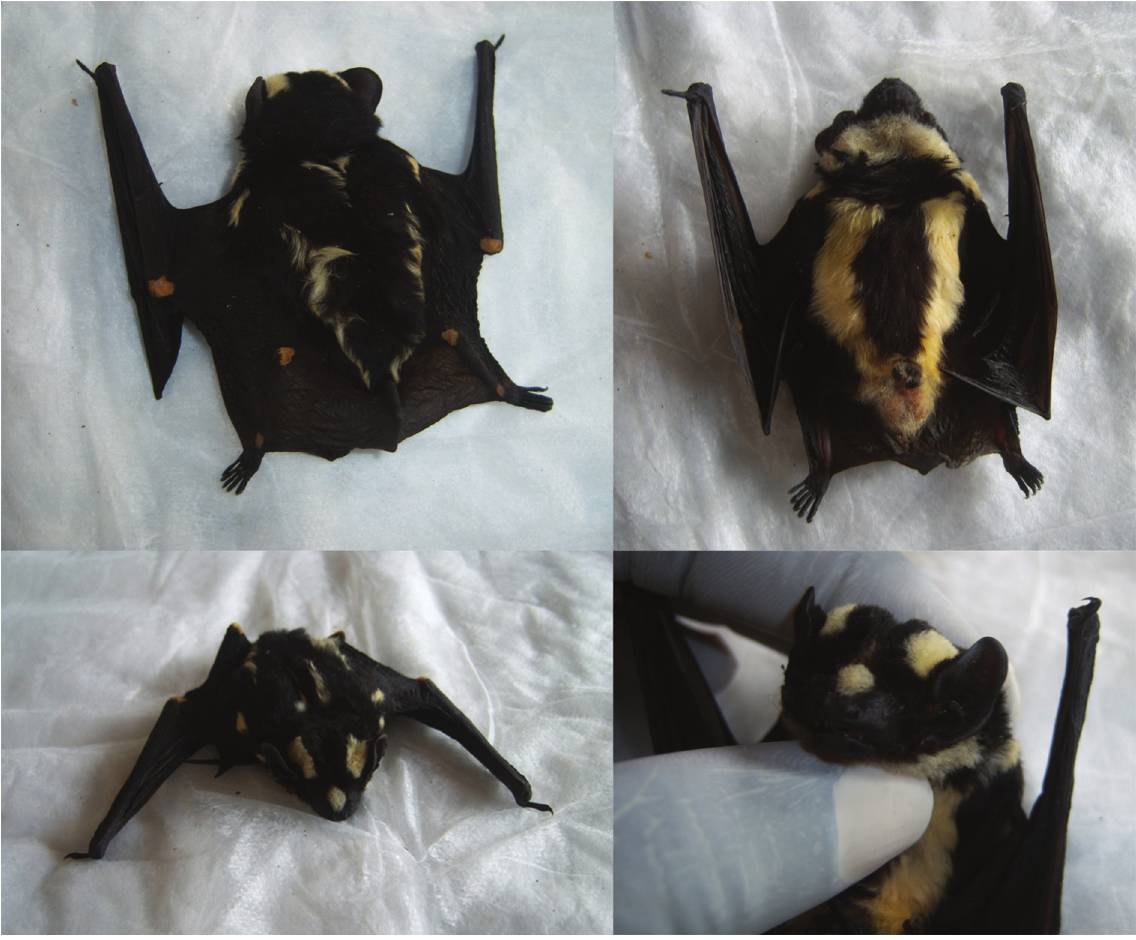
Fig. 2. Pelage pattern of the freshly collected Glauconycteris superba Hayman, 1939 specimen from Mbiye Island (RMCA a1.097-M-3153). Upper left: dorsal view, upper right: ventral view, lower left: anterior-dorsal view, lower right: detail of head and